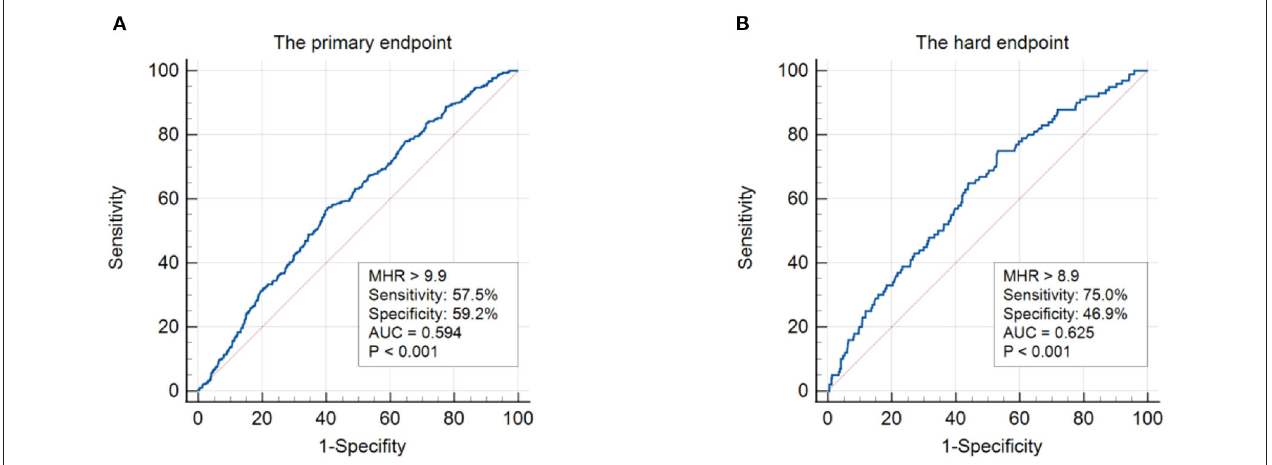
FIGURE 1 | ROC analysis showing the cut-off values of MHR to predict the primary endpoint (A) and the hard endpoint (B) . The primary endpoint was defined as the composite of overall death, non-fatal stroke, non-fatal MI, and unplanned repeat revascularization. The hard endpoint was defined as the composite of cardiovascular death, non-fatal stroke, and non-fatal MI. ROC, receiver operating curve; MHR, monocyte to HDL ratio; AUC, area under the curve; MI, myocardial infarction.